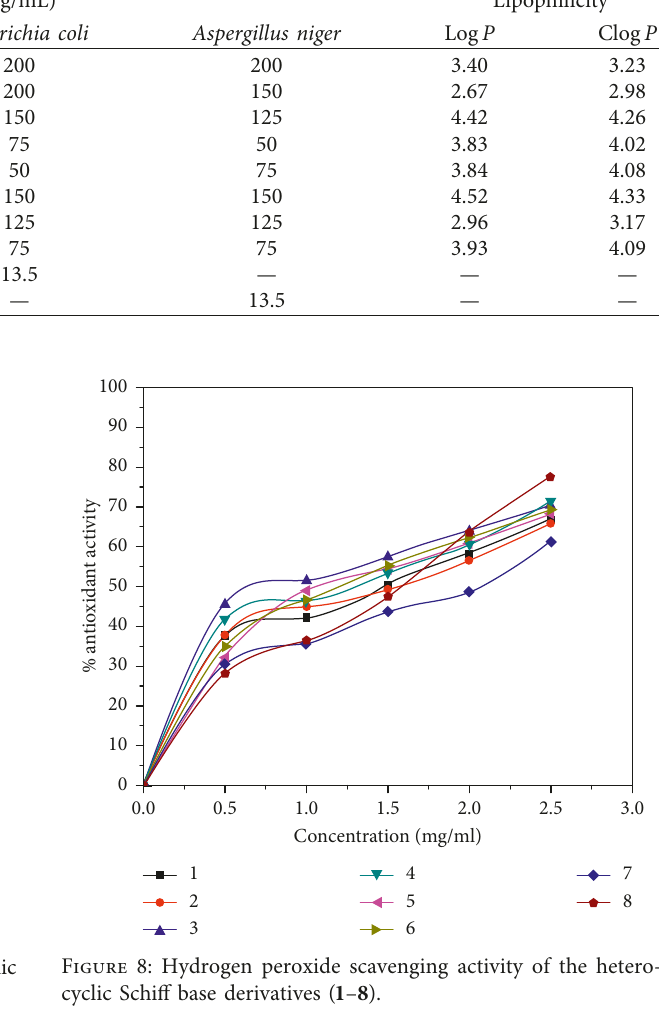
Table 2: Antibacterial activity of heterocyclic Schiff base derivatives ( 1 – 8 ) along with experimental “log P ” and the calculated “Clog P .” Control